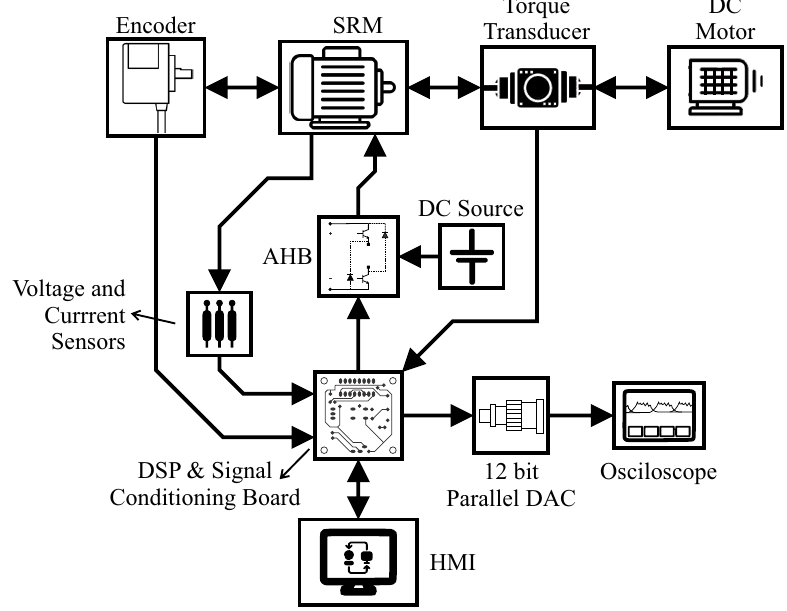
Figure 11. Experimental setup block diagram. HMI: human–machine